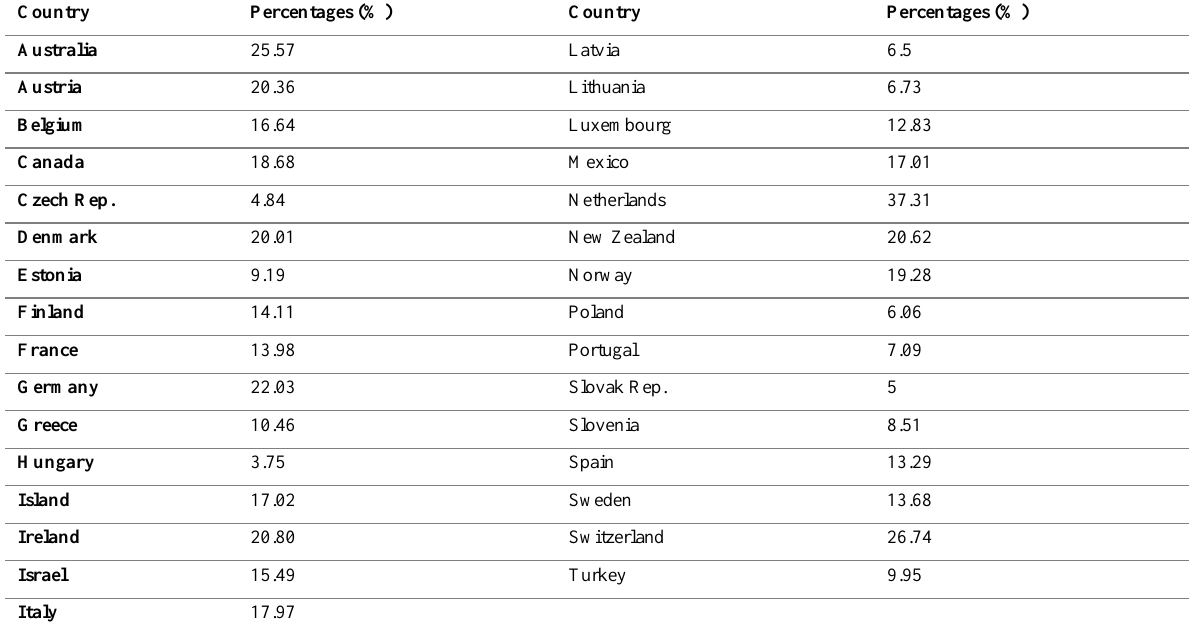
Table 2: Part-Time Employment Rates (Total, % of employment,